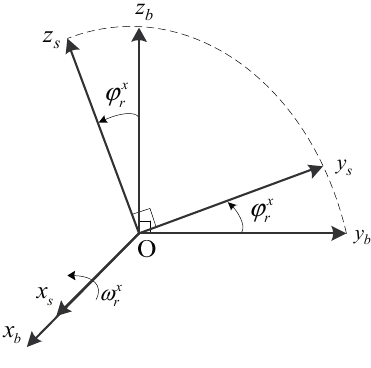
Figure 4. Rotation along with the X